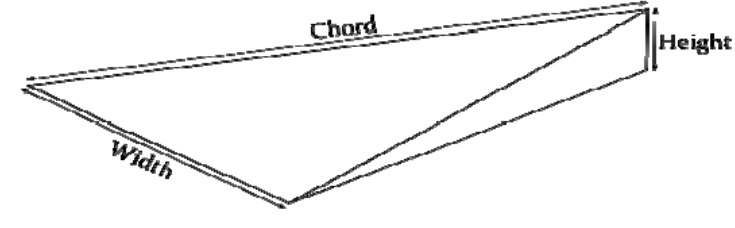
Figure 2. Diagram of a micro-ramp showing the dimensions.